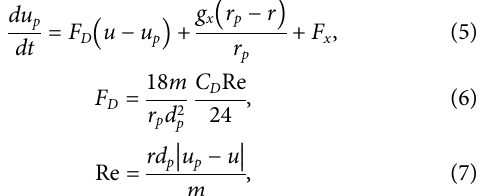
FIGURE 2 | The prototype stilling